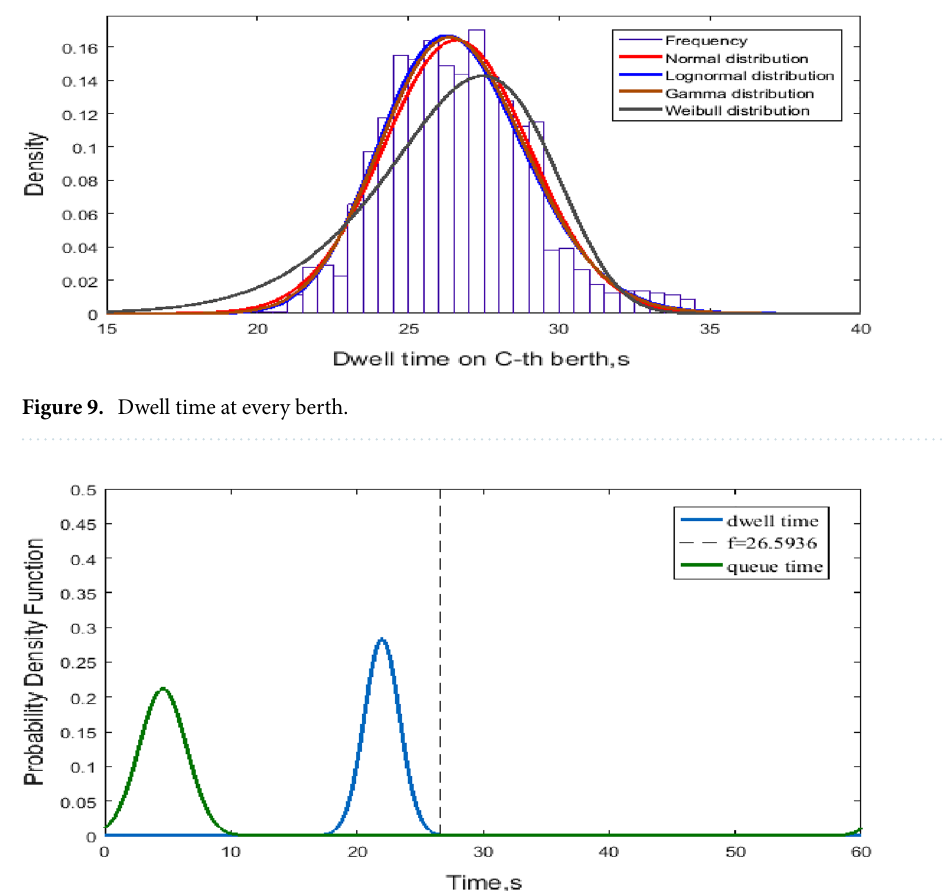
Figure 10. Joint normal probability density of dwell time and queue delay.